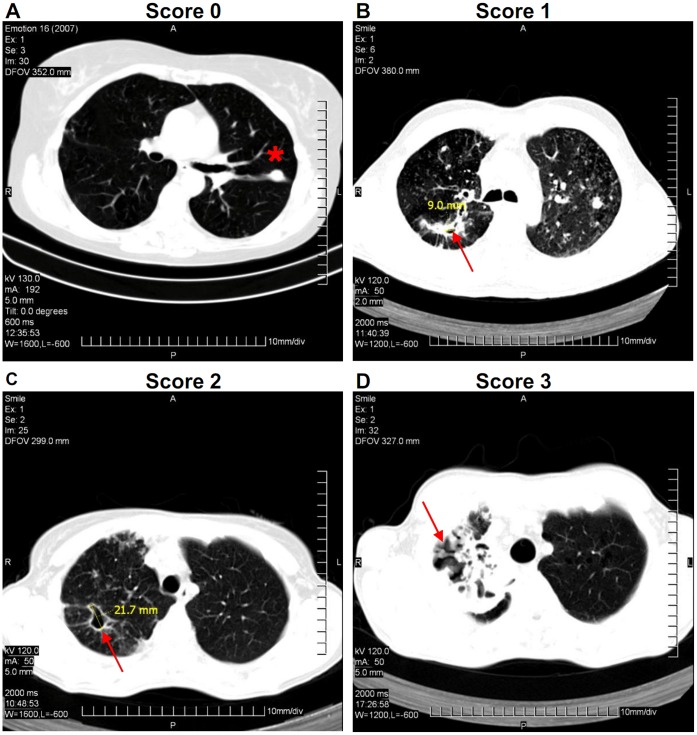
Evaluation of lung tissue destruction.Examples of X-ray computer tomograpy with different degrees of tissue destruction are shown. Lung destruction was evaluated based on the number and size of destructive (lucent) foci (see Methods for the details). A, score 0, no destruction; B, score 1, one small (<2 cm) destruction; C, score 2, one large (>2 cm) destruction; D, score 3, multiple lung destructions. Arrows, lung destructions. Asterisk, infiltrative focus without destruction.